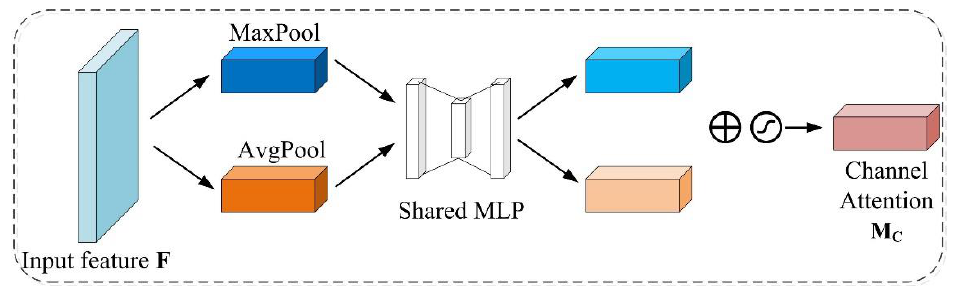
Figure 6. Channel attention structure.